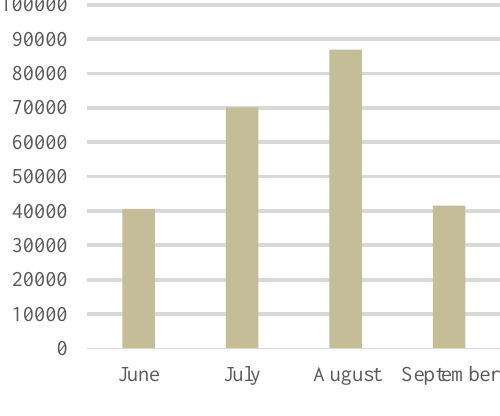
Figure 3. Number of visitors during the bathing season in